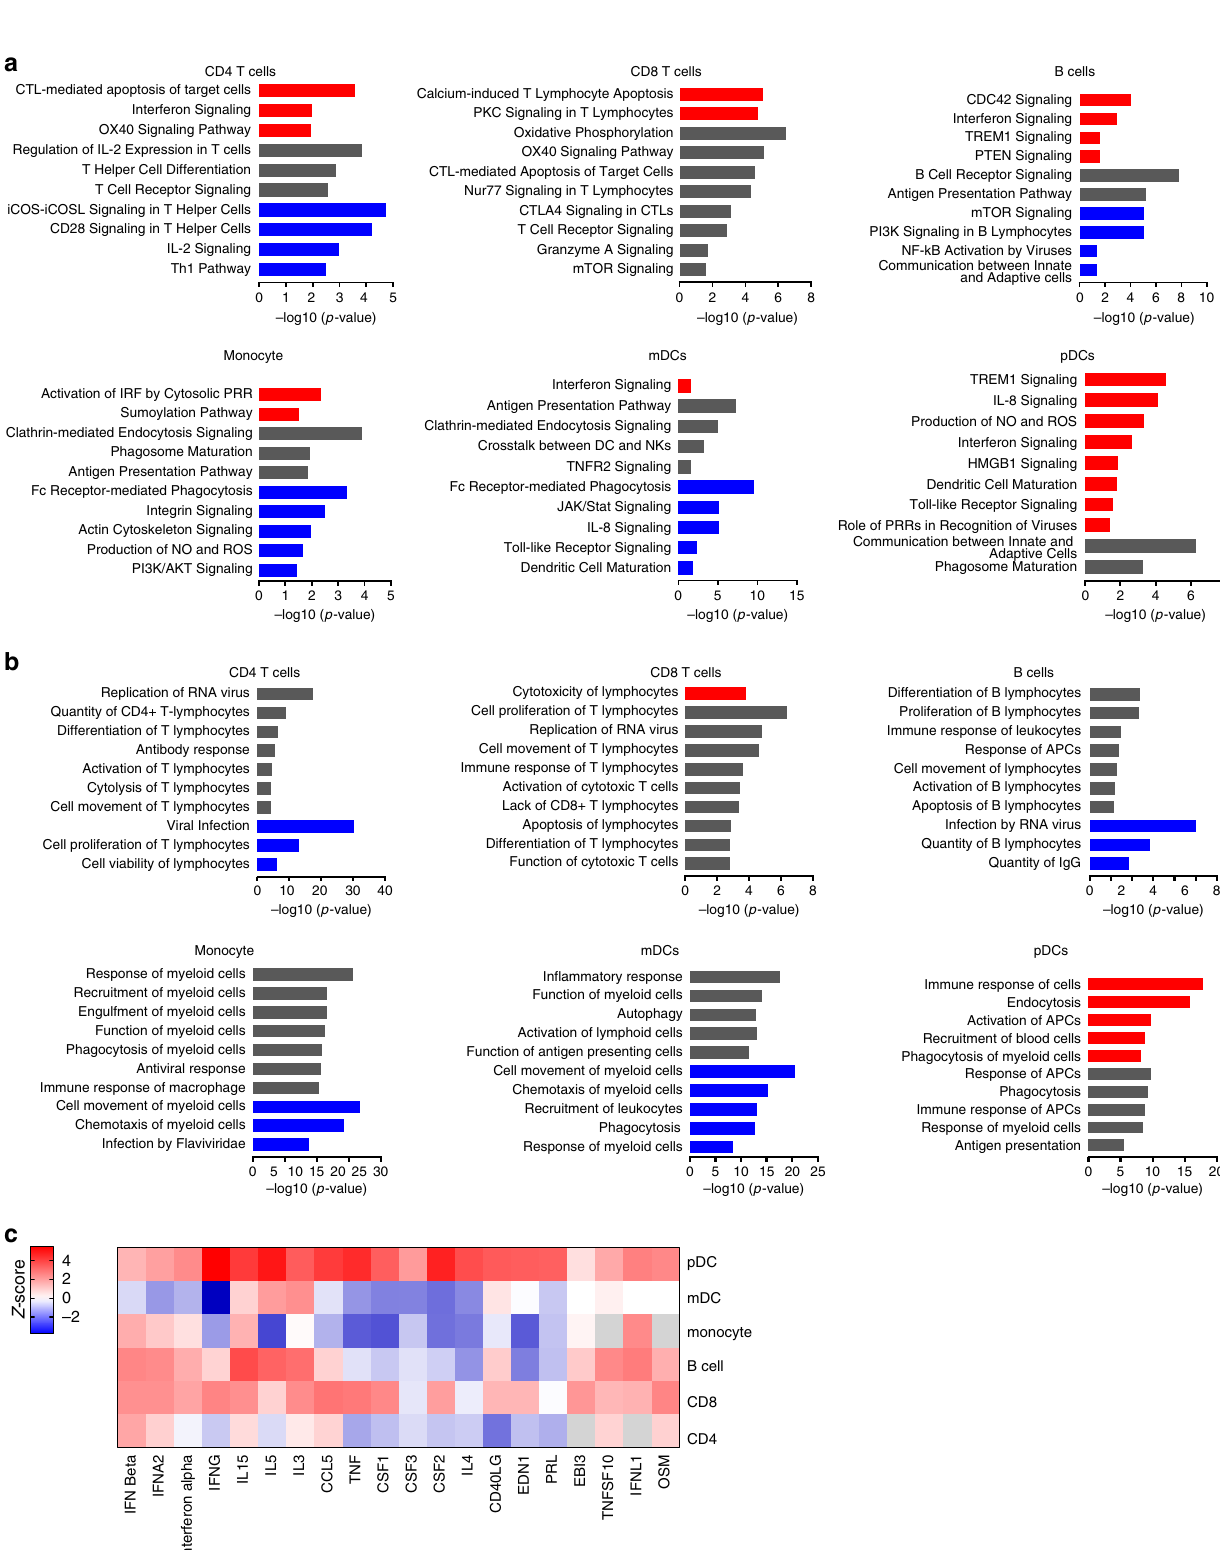
Fig. 2 Activation of antiviral immune defense pathways in pDCs from patients with ZIKV infection. a , b “ Canonical pathways ” ( a ) and “ Diseases and Functions ” ( b ) inferred by Ingenuity pathway analysis (IPA) from DEGs between ZIKV-infected individuals and noninfected individuals in indicated immune cell subsets. Red and blue denote functional pathways predicted to be up or downregulated, respectively; gray indicates indeterminate directional changes for the respective functional entity. c Predicted upstream regulators for genes differentially expressed between pDCs from ZIKV-infected individuals and noninfected individuals. Color coding re fl ects z -score, indicating activation or inhibition of the upstream regulators in ZIKV-infected patients compared to noninfected